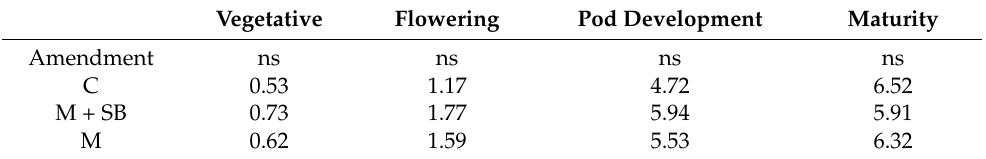
Table 6. Average aboveground biomass (t ha − 1 ) at the vegetative (30 January 2018), flowering (12 February 2018), pod development (21 March 2018) and maturity (4 April 2018) stage for the con- trol (C), manure (M) and manure plus rice straw (M + SB) amendment treatments tested in the 2017/18 dry season.